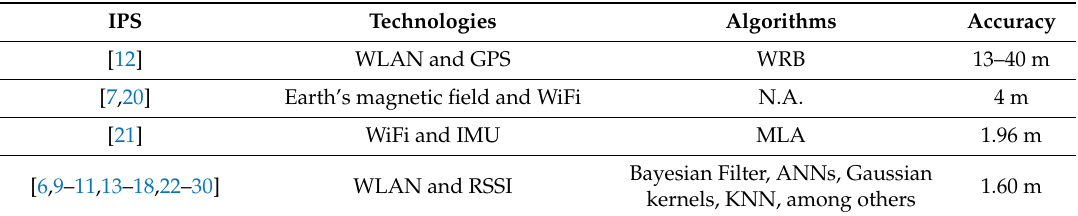
Table 1. Relevant works related to several techniques applied for Indoor Positioning Systems (IPSs). WRB,